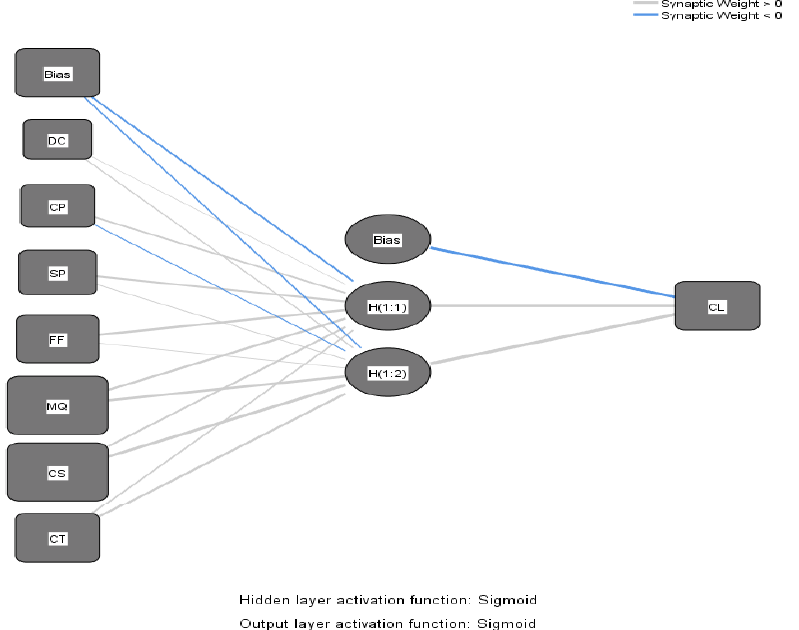
Figure 3. Neural Network Model. Source: Developed by the authors based on the data calculated with SPSS Statistics. Table 9. RMSE values for the ANN model.